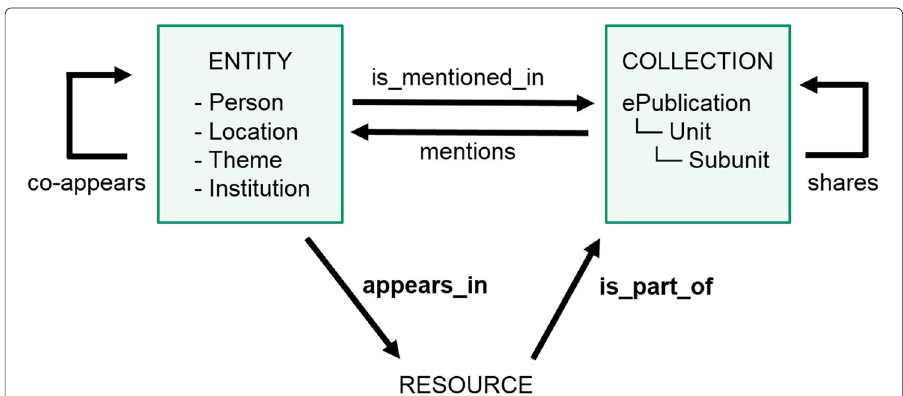
Fig. 1 Data structure. BLIZAAR data structure (nodes and